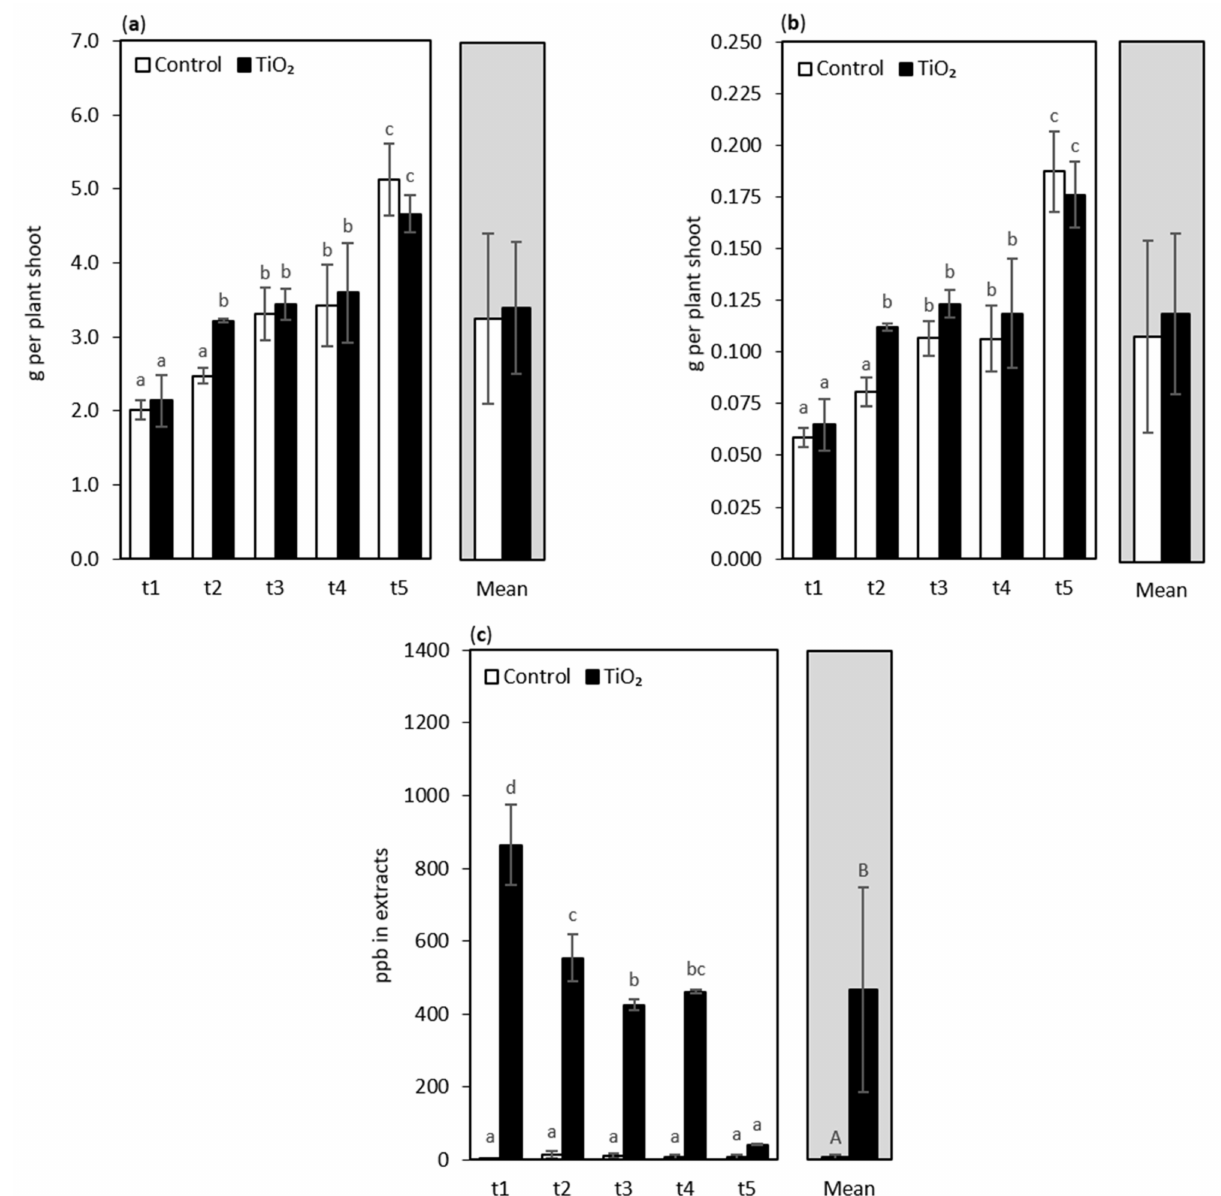
Figure 5. Fresh weight ( a ), dry weight ( b ), and Ti content ( c ) of oakleaf lettuce seedlings treated with TiO 2 -NPs applied on the leaves as a 0.75% suspension, while control plants were sprayed with deionized water. Plants were sampled 4, 7, 9, 11, and 13 days after treatment (sampling time: t1, . . . , t5, respectively). Lower-case letters above bars highlight significant differences for interaction effects, and capital letters indicate differences between the means for the treatment groups (NPs treated plants and control plants), according to Fisher’s test ( p ≤ 0.05). Missing letters indicate no significant differences. Error bars represent standard deviations ( ±